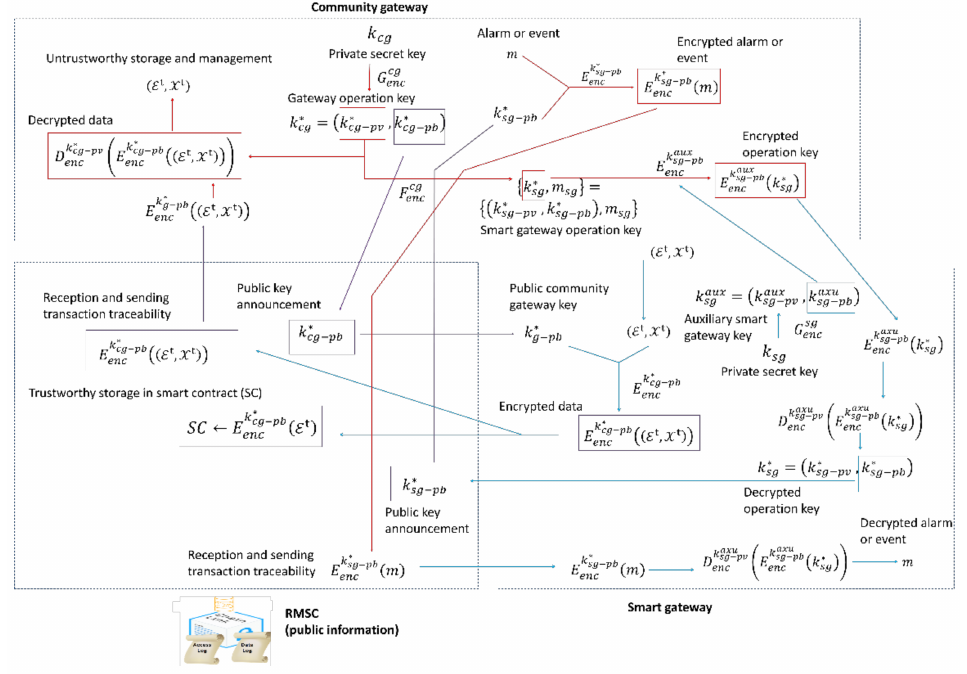
Figure 2. Architecture for the trustworthy secure resource monitoring